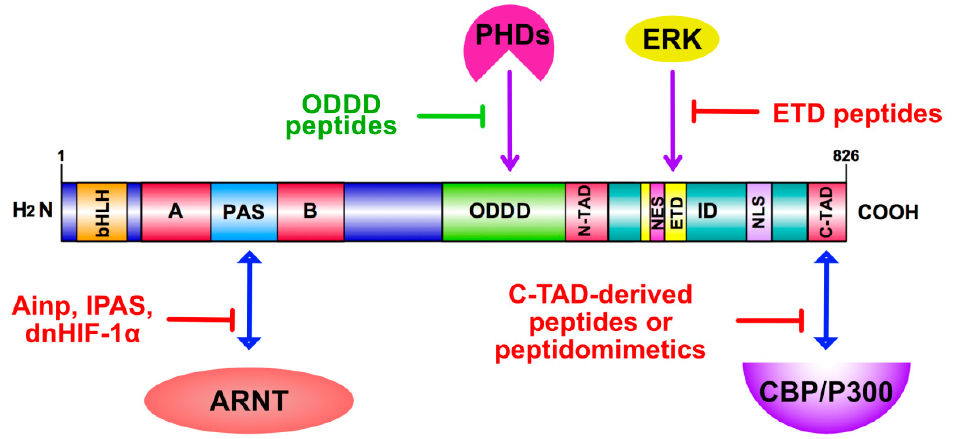
Figure 2. Peptide-mediated HIF α targeting. Peptides target the association of distinct HIF-1 α domains (as indicated) with components of the hypoxia signaling or transcription machinery, such as ARNT, PHDs and CBP/P300 (activating peptides in green, inhibiting in red). Modification of HIF-1 α by ERK and its phosphorylation-dependent nuclear interactions can also be inhibited by ERK Targeted Domain (ETD)-derived peptides.